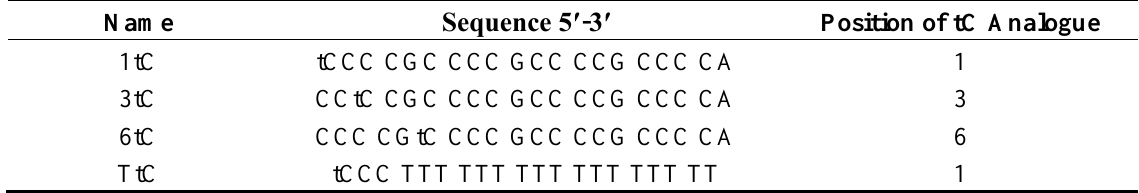
Table 1. Oligonucleotide sequences and their modification with